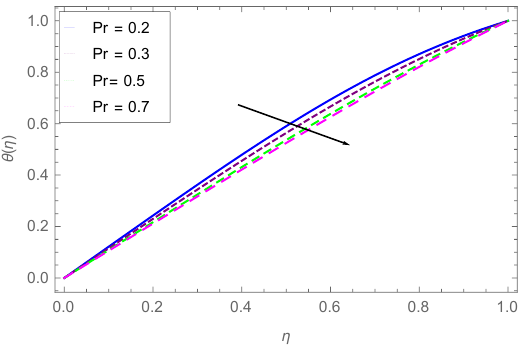
Figure 7. Plot depicting θ ( η ) dependence on Pr .